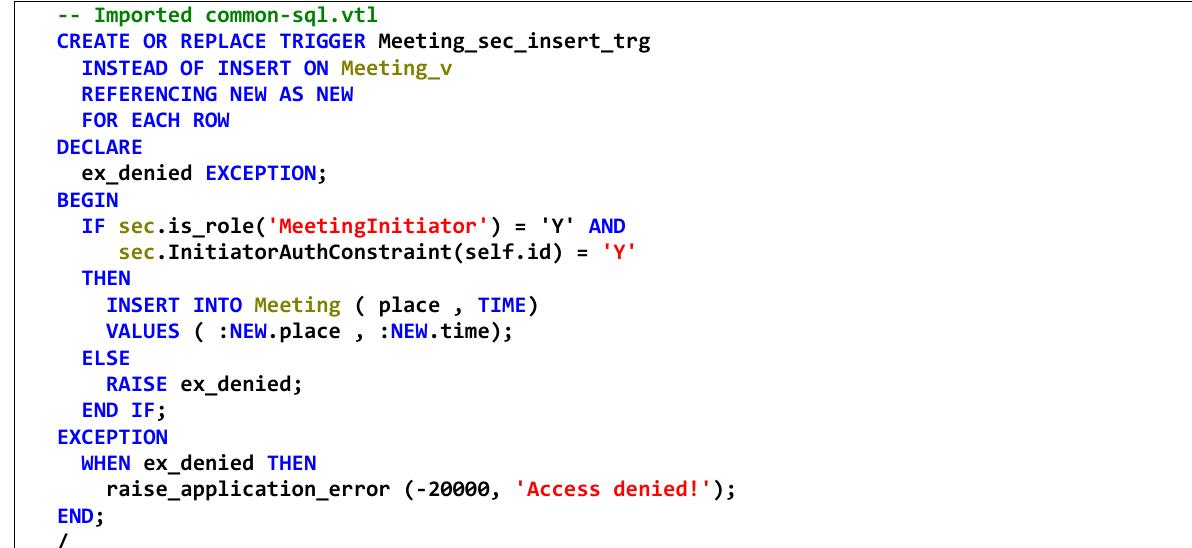
Figure 14. Transformed Insert authorisation